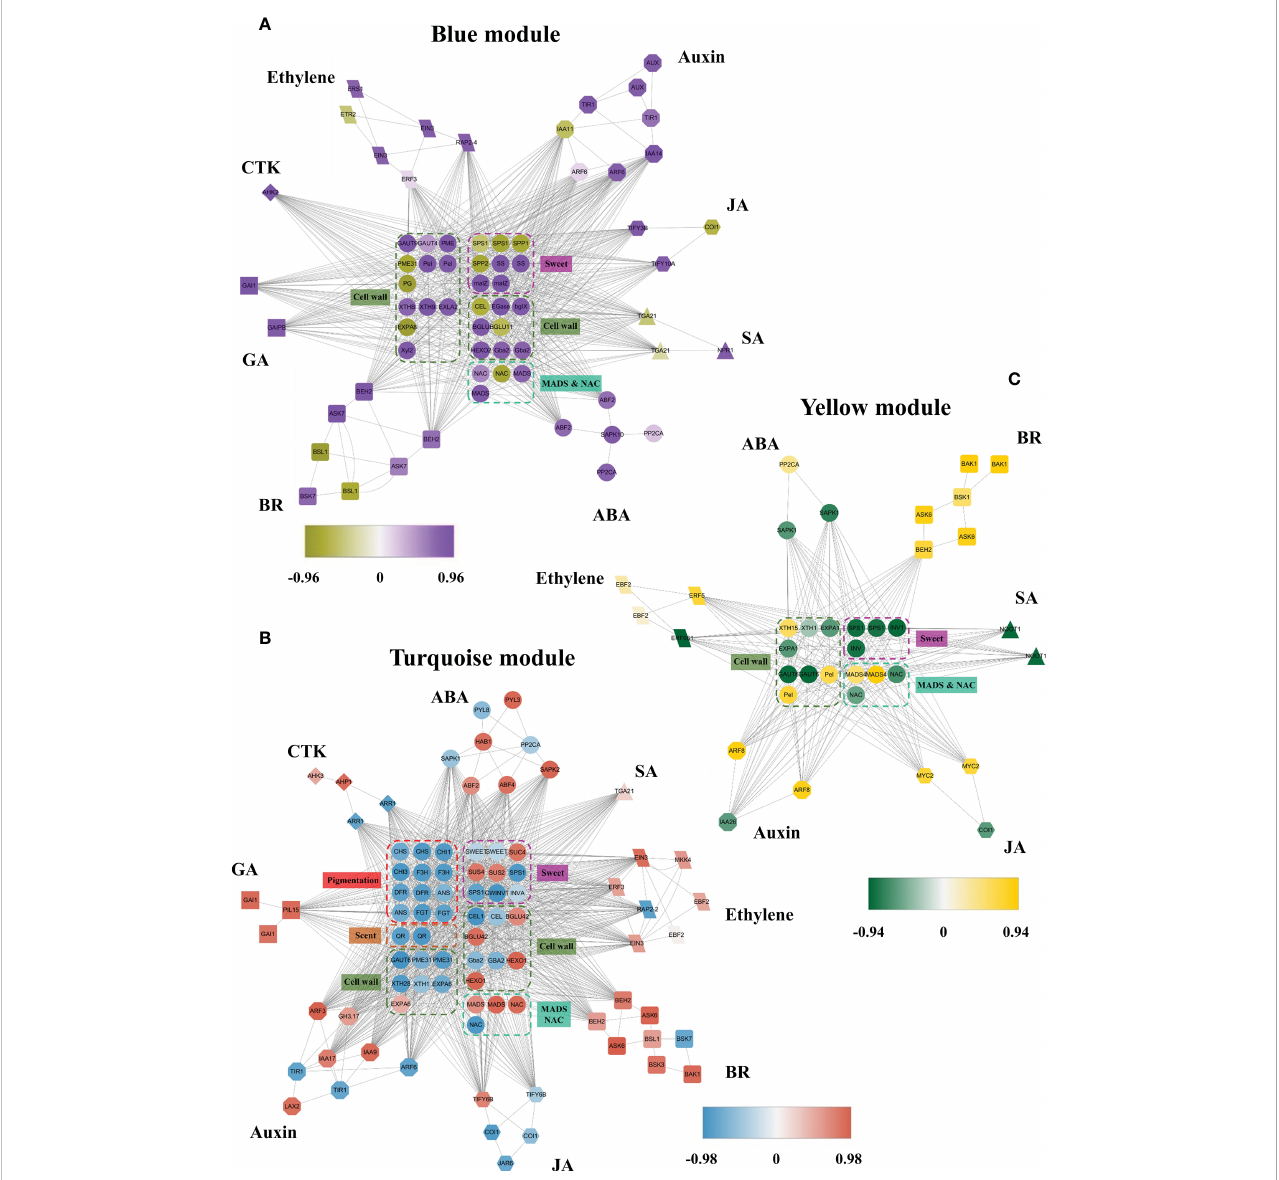
FIGURE 4 The coexpression networks of ABA and other phytohormone signaling pathways during receptacle ripening in blue, turquoise and tan modules. (A) The coexpression network in the blue module was negatively related to ripening based on WGCNA. (B) The coexpression network in the turquoise module was negatively related to ripening. CTK, cytokinin; SA, salicylic acid. (C) The coexpression network in the yellow module was negatively related to ripening. The full names of the isoforms are shown in Supplementary Dataset